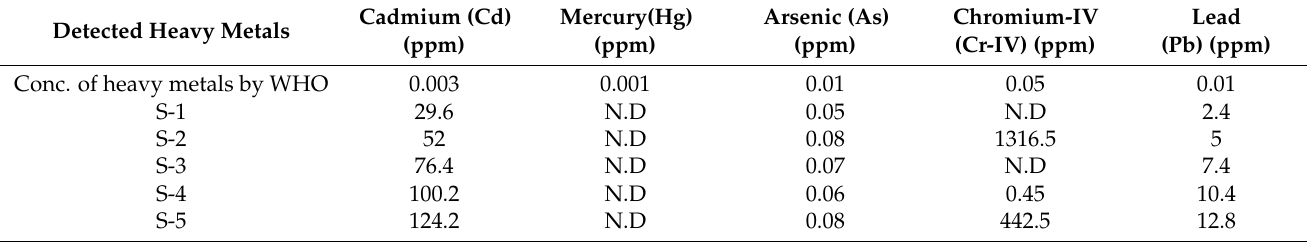
Table 1. Initial concentrations of heavy metals by Atomic Absorption Spectrometry (AAS) in ppm and permissible values of heavy metals in industrial waste water by WHO.